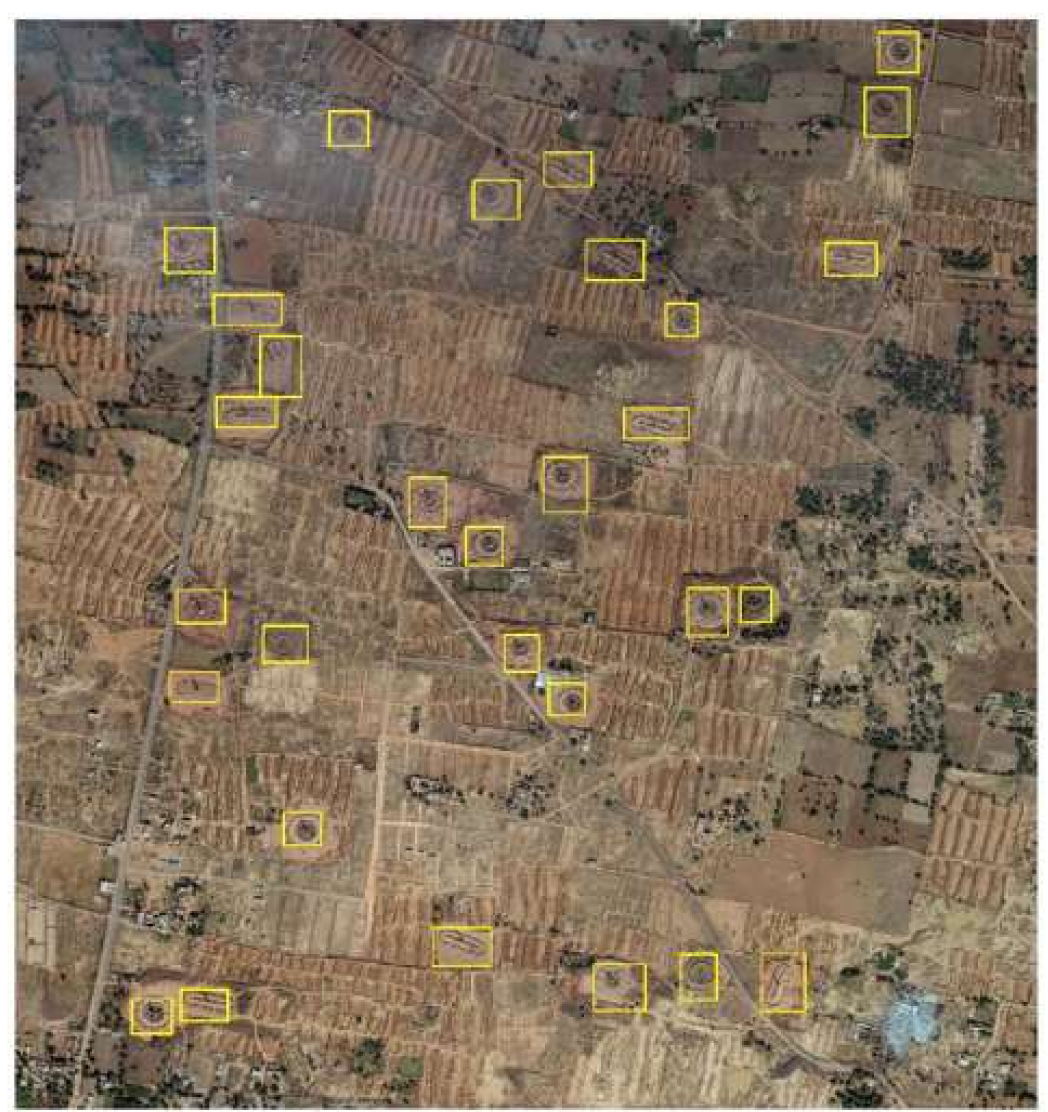
Figure 5. Extract of the output from the Faster R-CNN. Yellow bounding boxes show proposals of kilns. Within the extract shown all brick kilns present were identified with one commission error. Image data shown from Google Earth provided by Digital